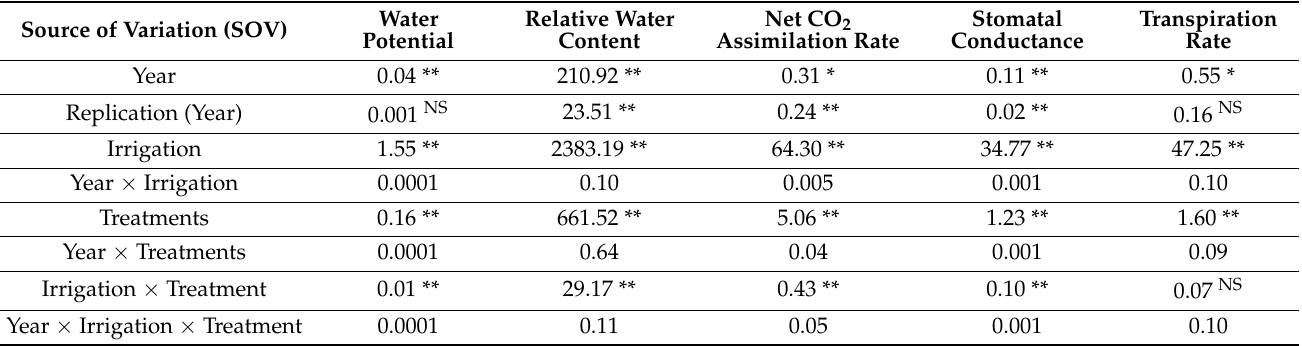
Table 1. Analysis of variance table for water relation and gas exchange parameters of wheat crops.